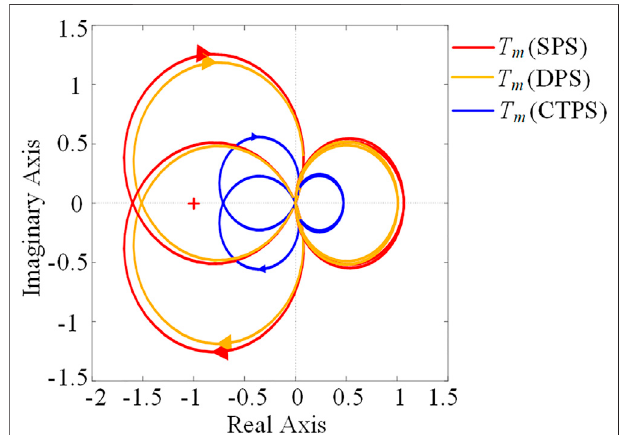
FIGURE 7 | Nyquist plots of closed-loop minor loop gain T m .